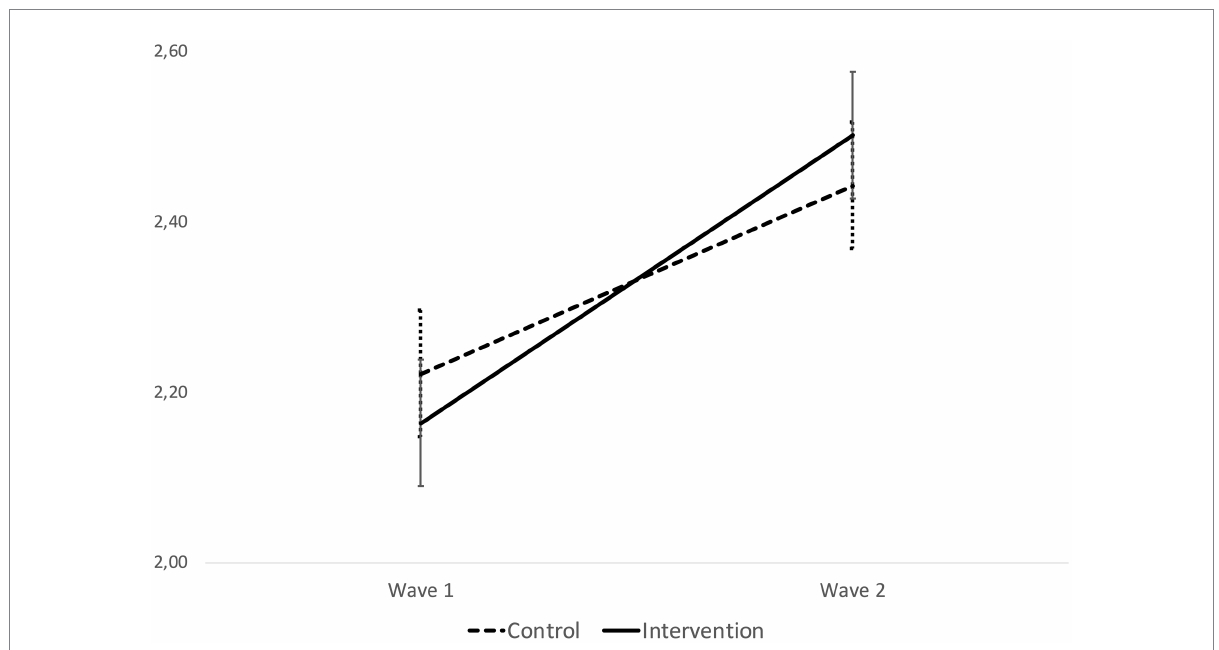
FIGURE 2 Trends in frequency of home mathematics-related activities from baseline to post-intervention for participants in the Born-to-Count intervention versus control condition. Error bars represent Standard Errors.